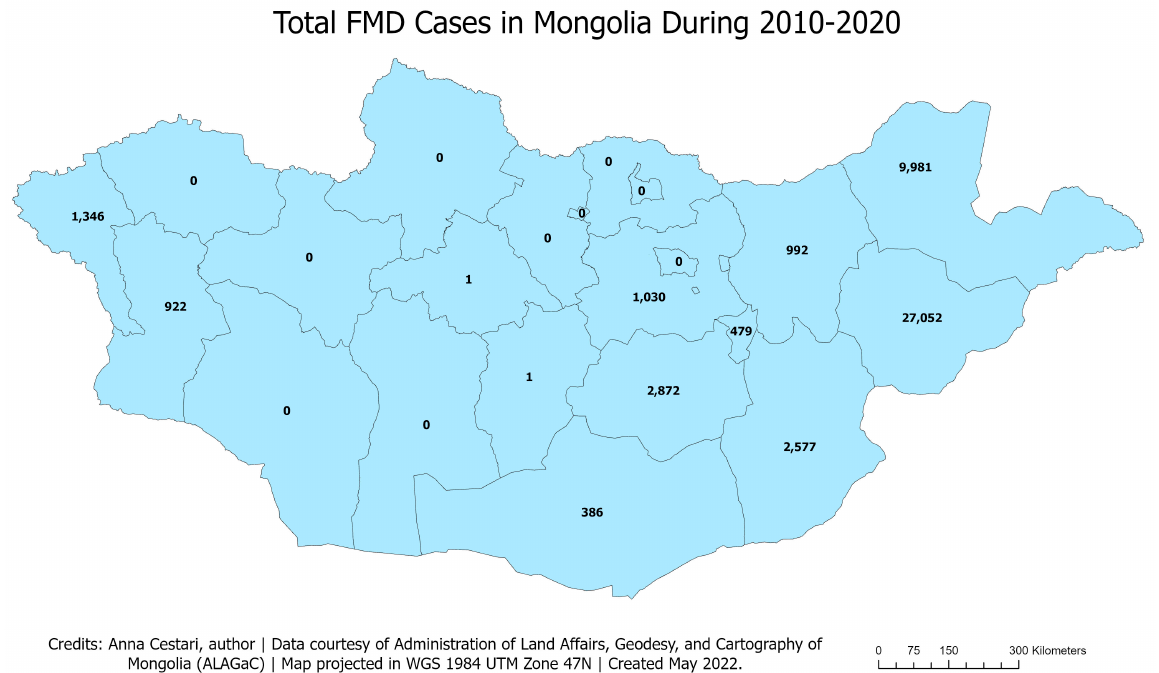
Figure 2. The total number of cases of FMD in livestock in Mongolia between 2010 and 2020 by province.